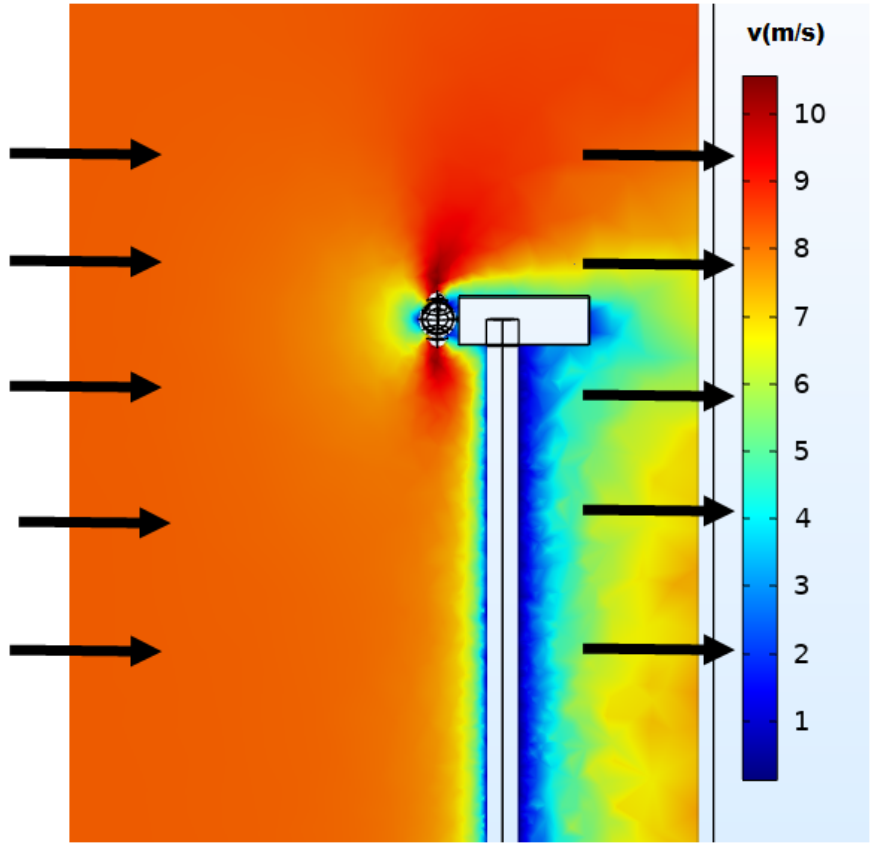
Figure 6. Wind speed using the software.